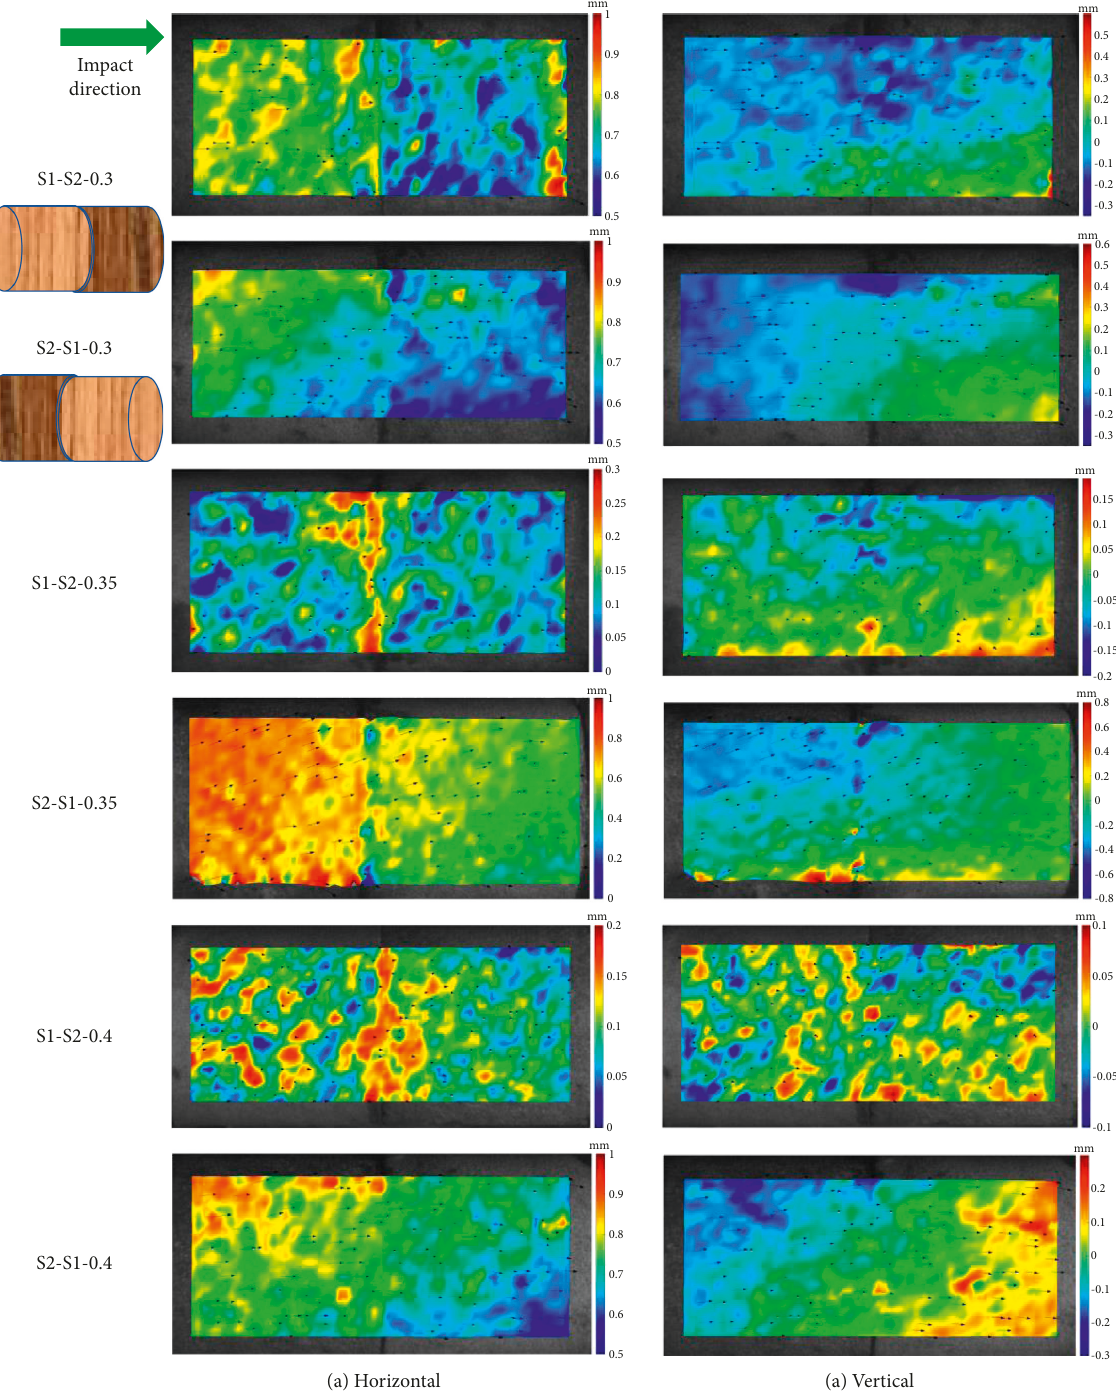
Figure 12: (a) Horizontal and (b) vertical displacement fields of composite samples